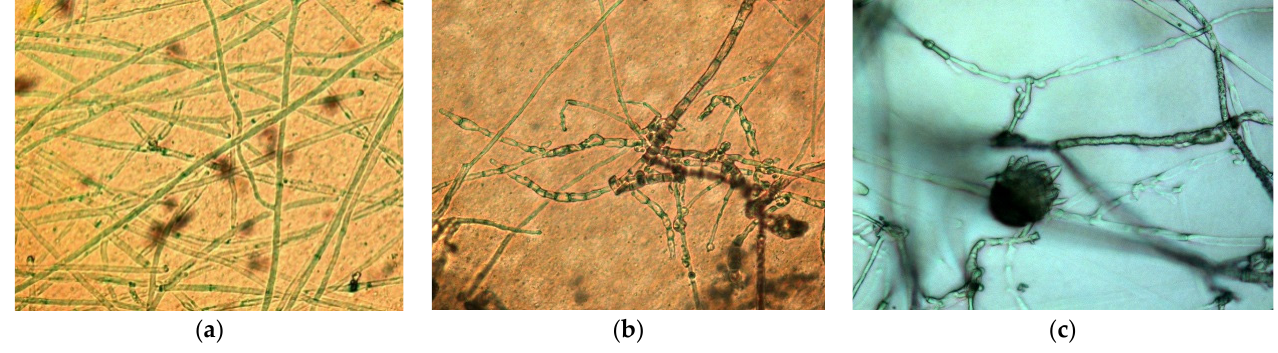
Figure 6. F. graminearum BZR 4 without an antagonist bacterium ( a ), shortening and hyphae branch-